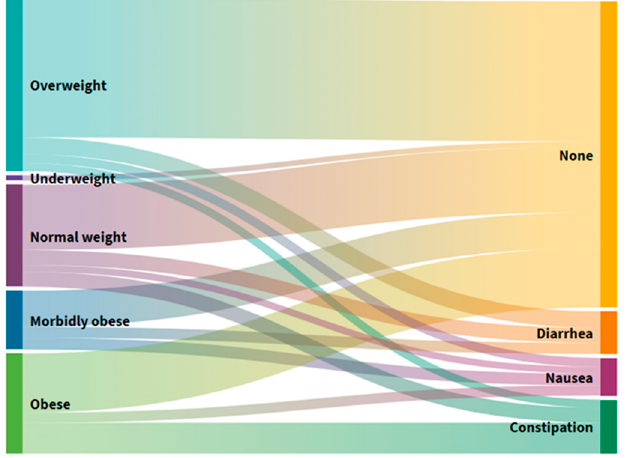
Figure 4. Alluvial diagram of the distribution of users according to the BMI groups and gastrointestinal symptoms.